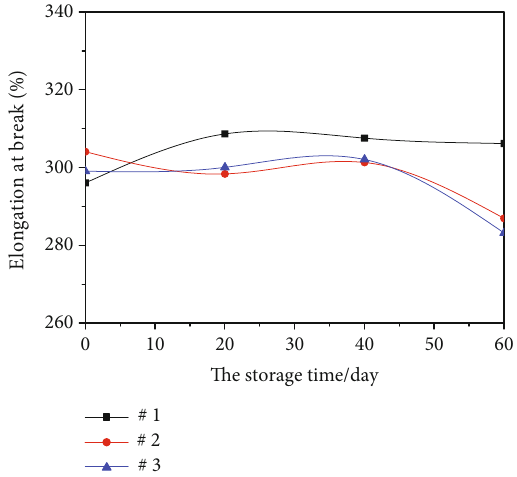
Figure 9: The tensile elongation at break values of the reclaimed rubber vulcanizates revulcanized after storing for various storage periods. The tensile elongation at break values of the revulcanized reclaimed rubber was less a ff ected with storage time of the reclaimed